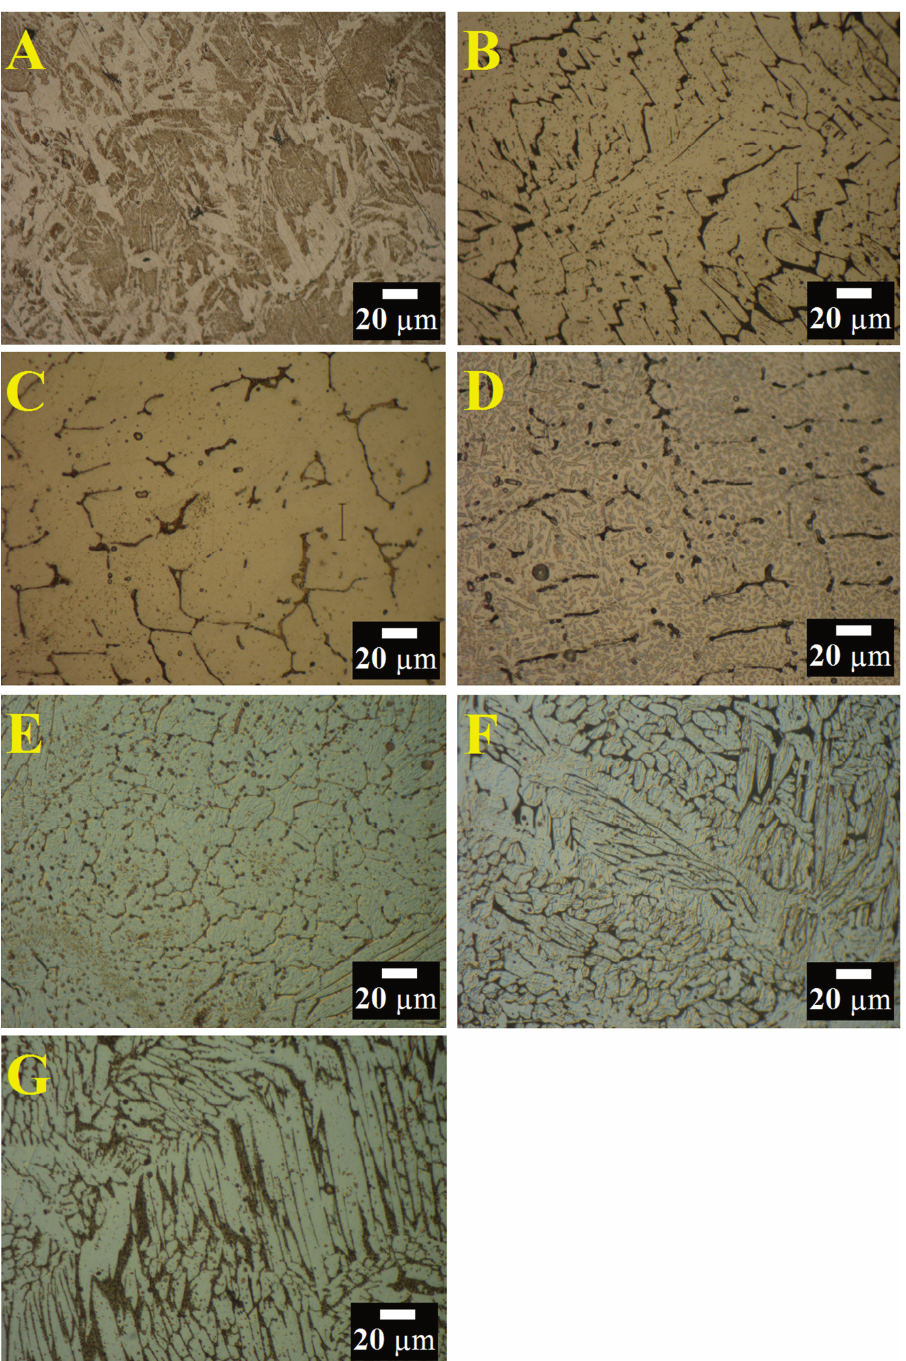
Figure 7: Optical microscope micrographs of the selected Fe-based alloys which were produced by using metallothermic reduction process (A: Unalloyed iron, B: 304, C: 305, D: 201, E: 301, F: 316, G: